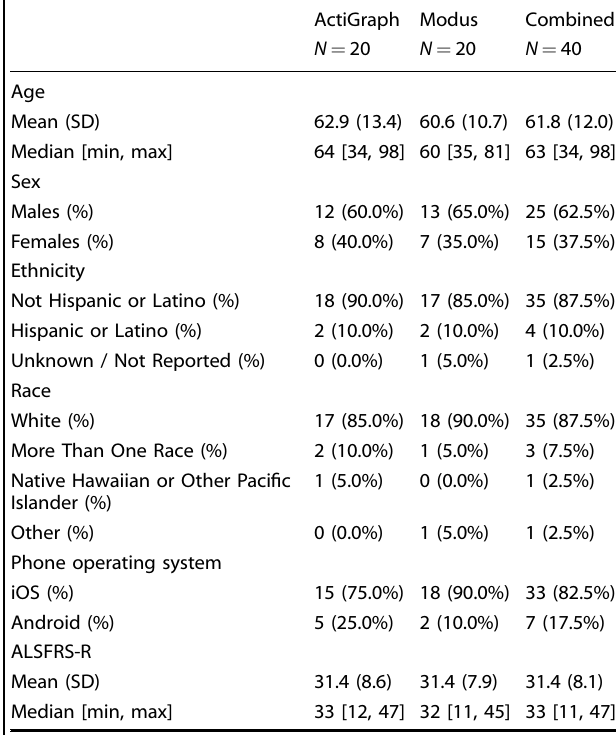
Table 1. Baseline demographic and clinical characteristics.